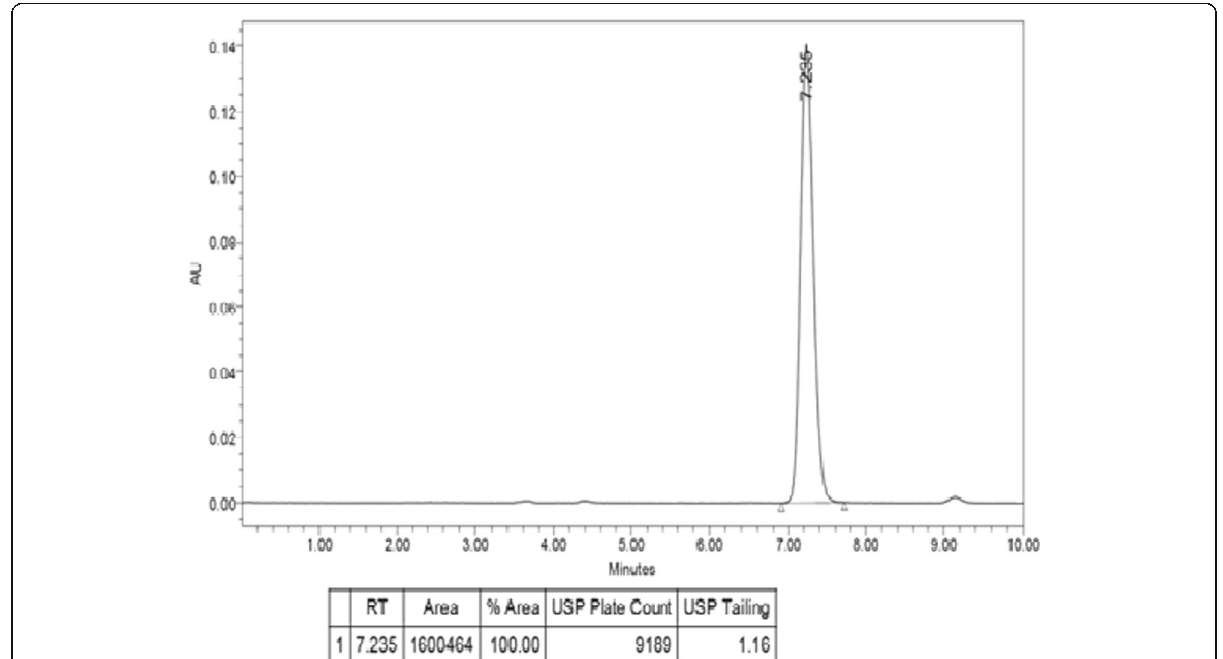
Fig. 4 The chromatogram of standard solution of